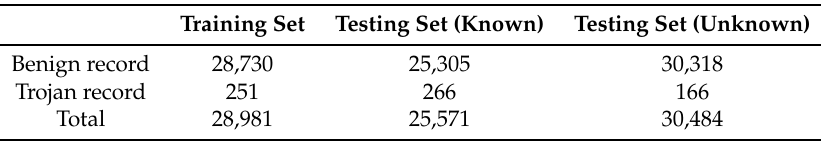
Table 3. Experimental data.